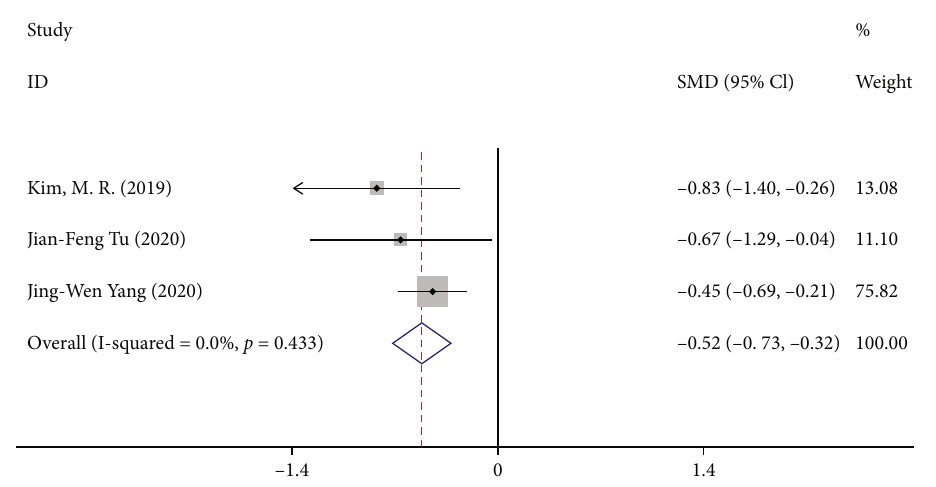
Figure 4: Forest plot of comparison. Acupuncture vs. sham acupuncture. Outcome: change in NDI from baseline to week 16.